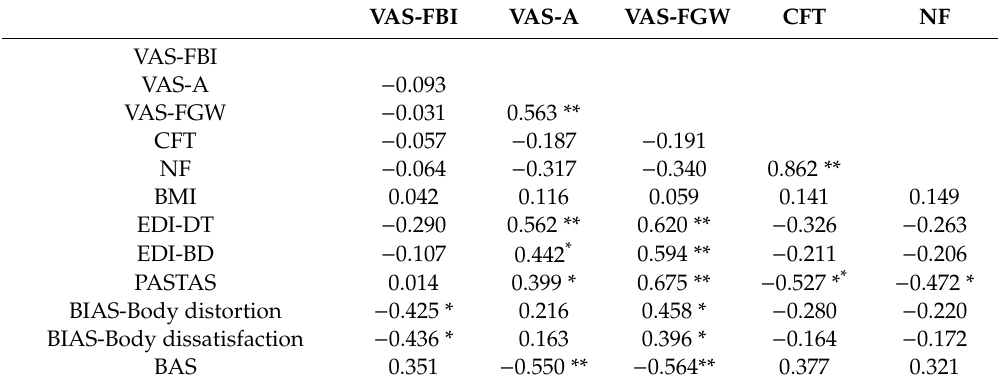
Table 6. Correlations between ED measures and VR body exposure responses in patients with